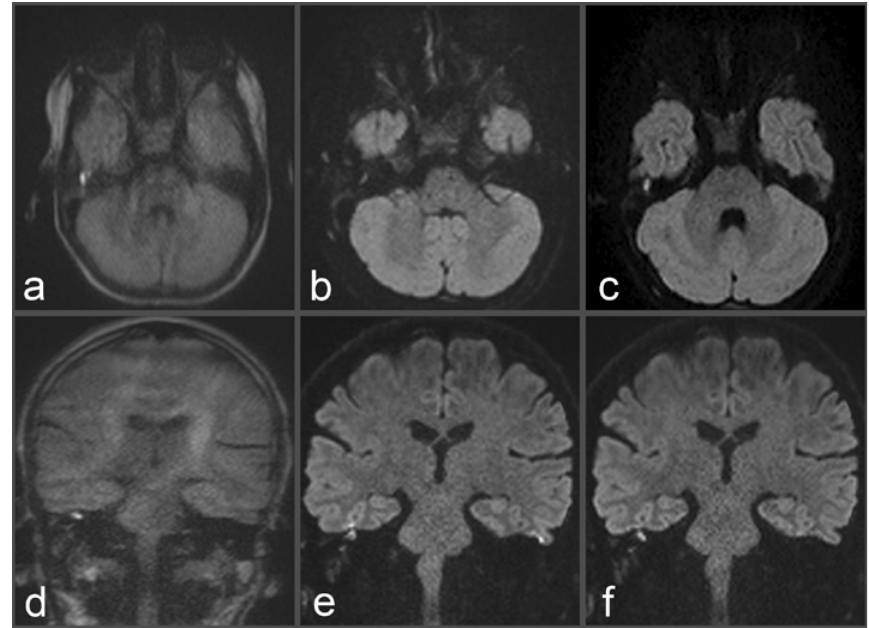
Figure 3. Images of a 54-year-old patient with a suspected cholesteatoma on the right side. ( a ) and ( d ) tseDWI (axial and coronal slice orientation). ( b ) and ( e ) uncorrected rsDWI (axial and coronal slice orientation). ( c ) and ( f ) top-up-corrected rsDWI (axial and coronal slice orientation). tseDWI images show an elongated hyperintense middle-ear lesion on the right side, which could be confirmed as a cholesteatoma after histopathological examination. The lesion is hardly visible in both uncorrected rsDWI images (especially on the axial images) and exhibits a geometrical distortion with a bent-like appearance on both slice orientations. Additionally, two punctiform hyperintensi- ties are visible on both sides at the height of the temporal cortex. Both hyperintensities are missing on the tseDWI and the topup-corrected rsDWI images, strongly indicating that these hyperintensi- ties represent artifacts. On the topup-corrected rsDWI images, the cholesteatoma on the right side exhibits a better contrast compared to uncorrected rsDWI, and geometrical distortions are compa- rably minor. Additionally, topup-corrected rsDWI does not show the above-described likely false- positive lesions at the border zone between bone and brain tissue.